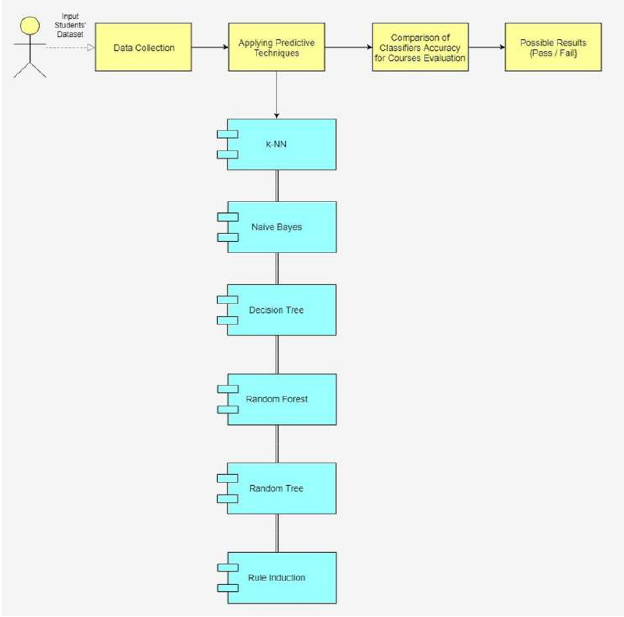
Fig. 1. Proposed data mining based predictive